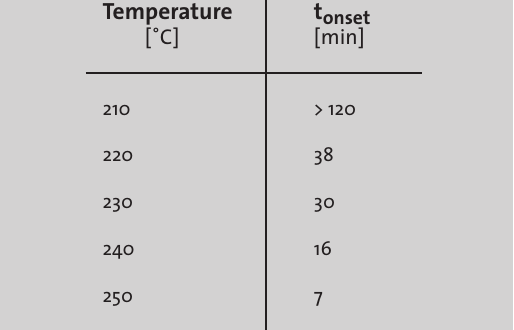
Table 3: Dependencies of the time t onset for a 20% rise in | h * ( w )| as a function of tem- perature. Fig. 6: Melt stability of the Pglass at the temperatures